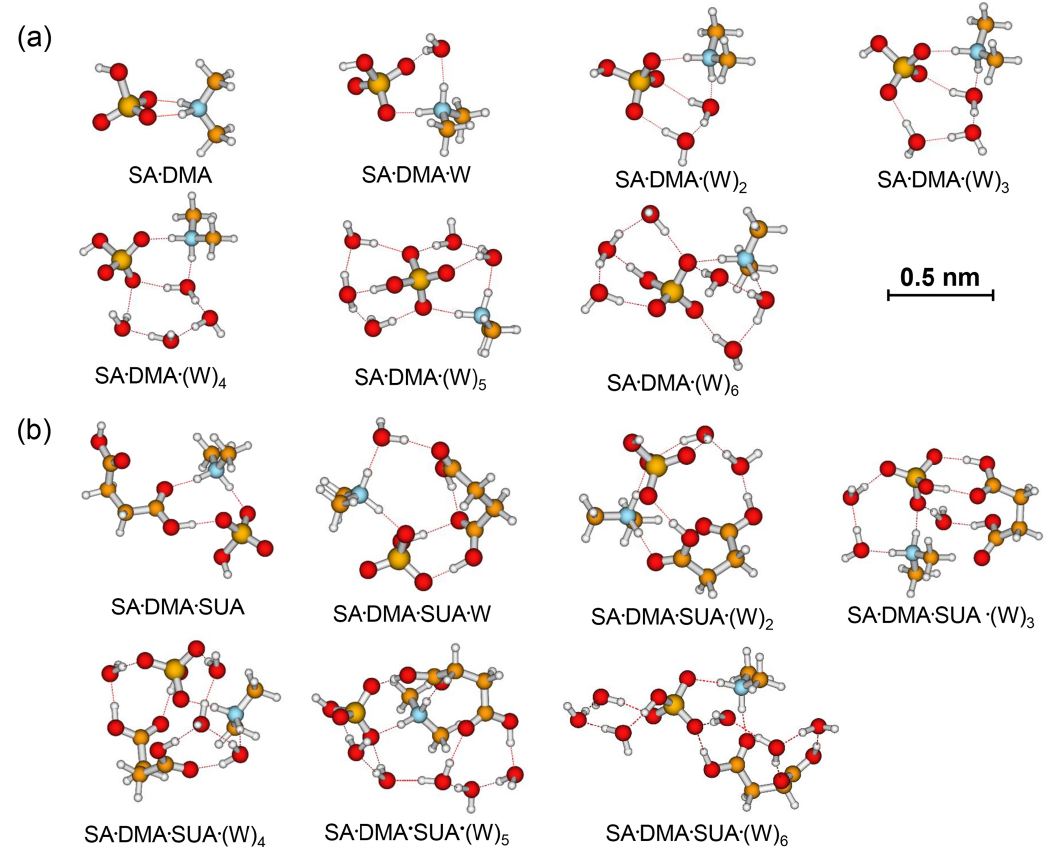
(cid:113) DMA clusters and the clusters with one SUA addition. The hydration is with zero